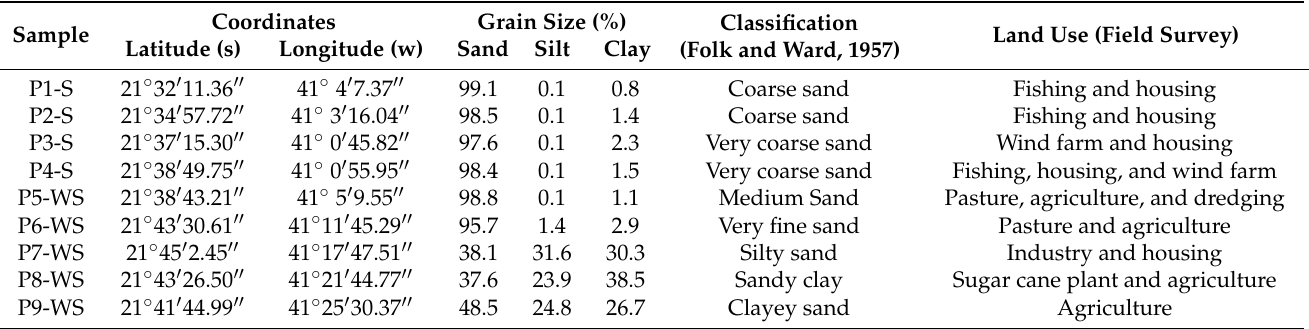
Table 4. Localization of sampling stations, particle size distribution, granulometric classification, and land use.